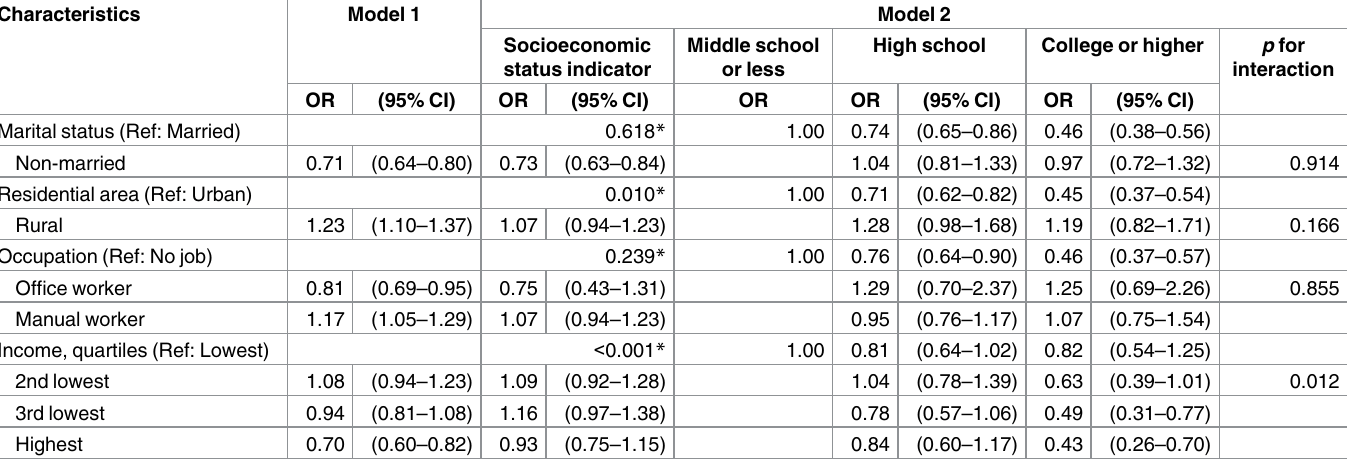
Table 7. Adjusted results of the main and interaction effectsof each socioeconomic status indicator and education on obesity in women.